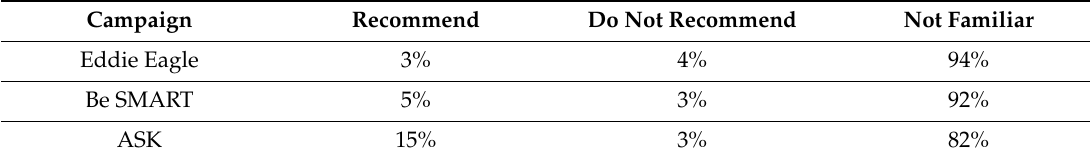
Table 2. Residents’ familiarity with gun safety campaigns.